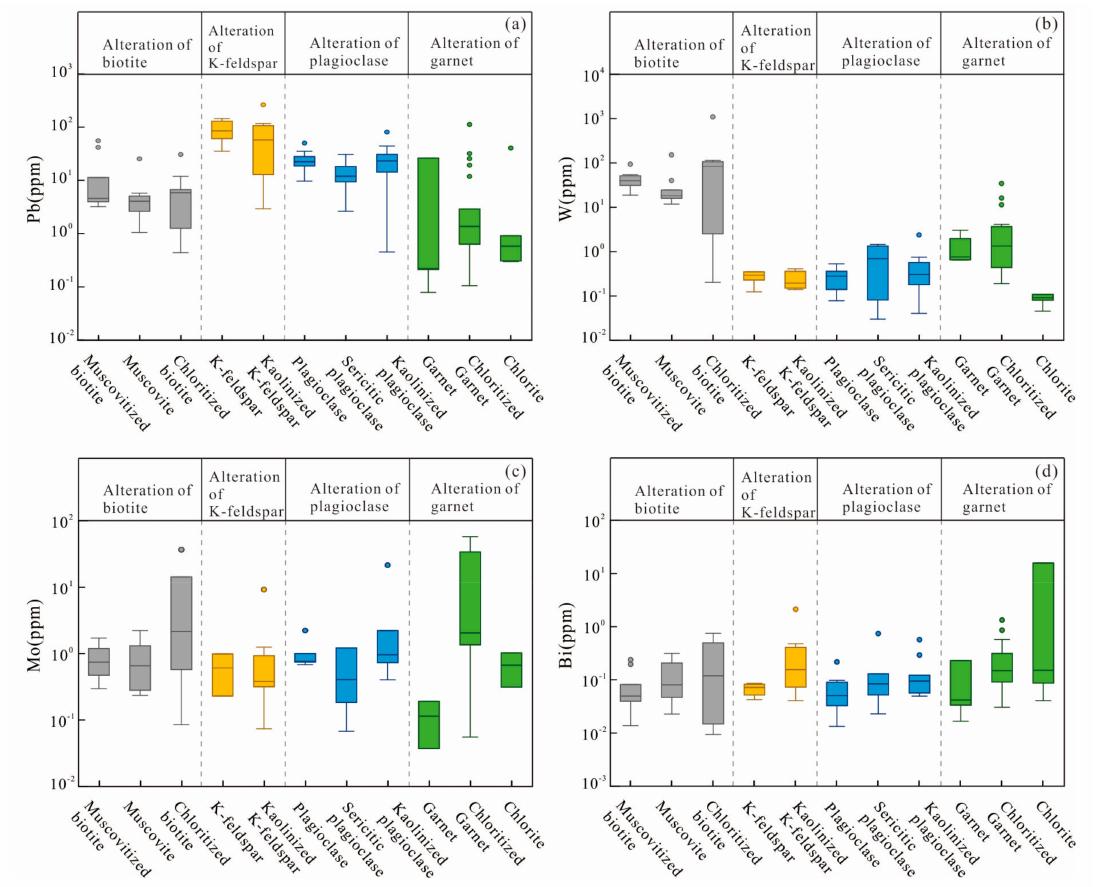
Figure 7. Box plots of ( a ) Pb, ( b ) W, ( c ) Mo and ( d ) Bi concentrations of the main silicate minerals and alteration minerals in granites and